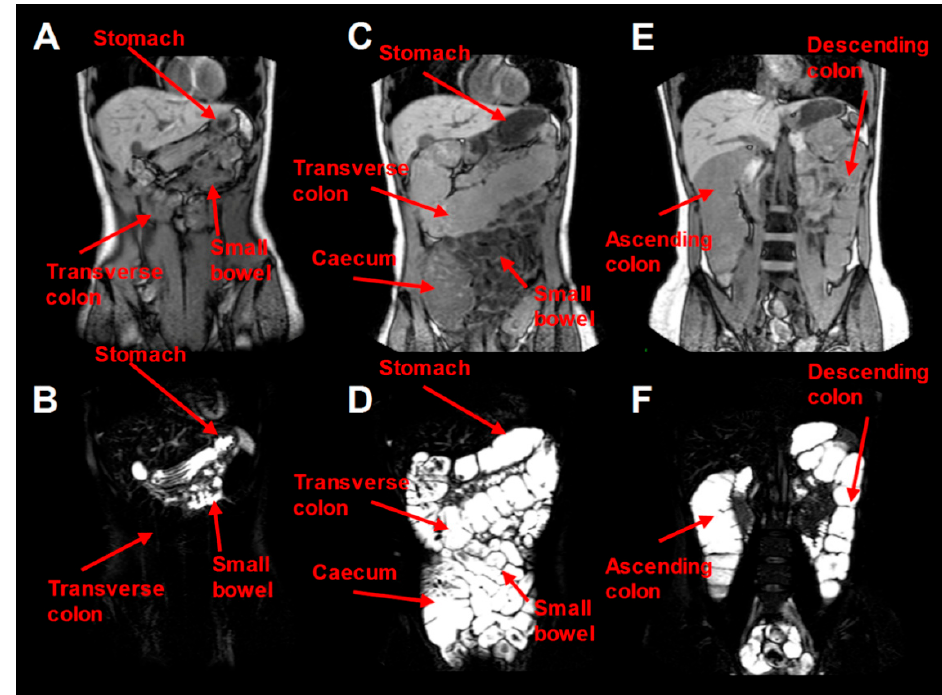
Figure 2. MRI quantification of water colonic content of one volunteer after ingestion of a single 2 L PEG electrolyte scheme. ( A , B ) concern fasting baseline conditions. White colour stands for water presence and black colour for water absence. In ( B ), water was found in the small bowel and the stomach (limited resting fluid) but not in the transverse colon. ( C – F ) conditions appear immediately after the ingestion of the 2 L PEG dose and therefore in ( D ) water was found in the stomach, the cecum and the transverse colon while ( F ) is a posterior image and represents water appearance in the ascending and descending colon. Reproduced from [25], Blackwell Publishing LTD, 2014 with